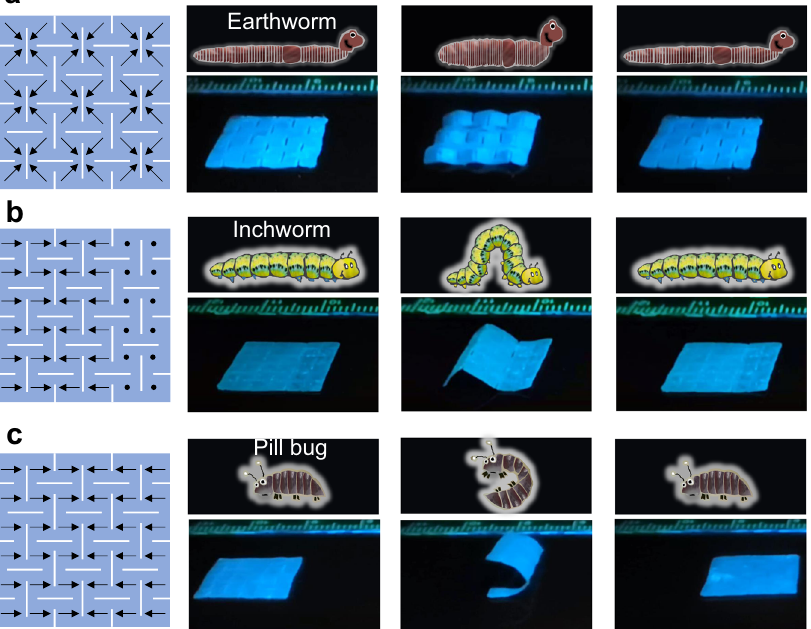
Fig. 6 Locomotion modes of soft robots that are fabricated from the MRSM kirigami fi lm but with different laser written magnetization patterns. The soft robots can mimic the peristalsis motion of an earthworm ( a ), crawling motion of an inchworm ( b ), and rolling motion of a pill bug ( c